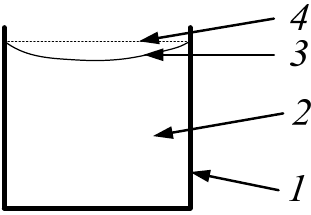
Figure 2. Binder volume change during curing: 1—utensil; 2—stagnant binder; 3—top surface of stagnant binder; 4—top surface of liquid binder.